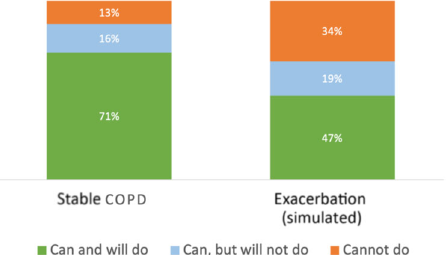
Fig. 1 Distribution of clinical groups of inspiratory ability, based on measured PIF at stable COPD (left) and simulated 20% reduction in PIF during an exacerbation (right) 13 . ‘ Can and will do ’ : patients with a typical PIF ≥ than the optimal PIF for their device; ‘ Can, but will not do ’ : patients with a typical PIF below the optimal PIF for their device, but able to generate maximum PIF ≥ the optimal PIF; ‘ Cannot do ’ : patients with both their typical and maximum PIF < optimal PIF for their